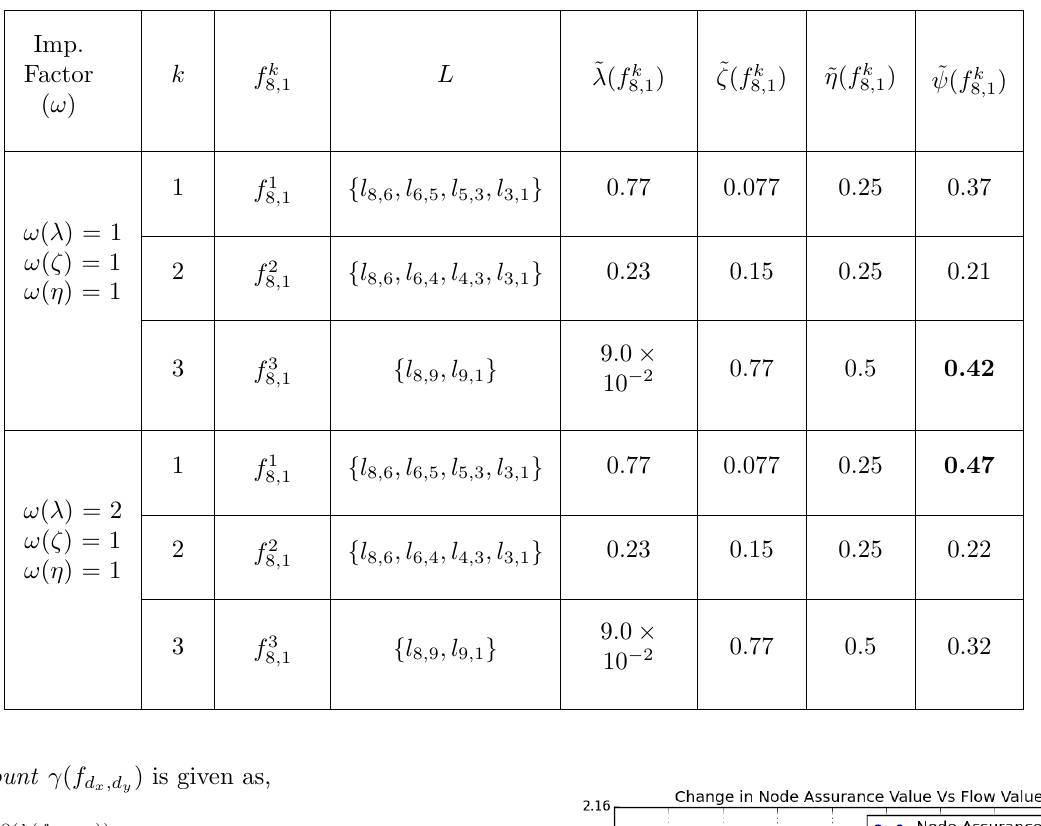
Table 1. Calculation of flow value